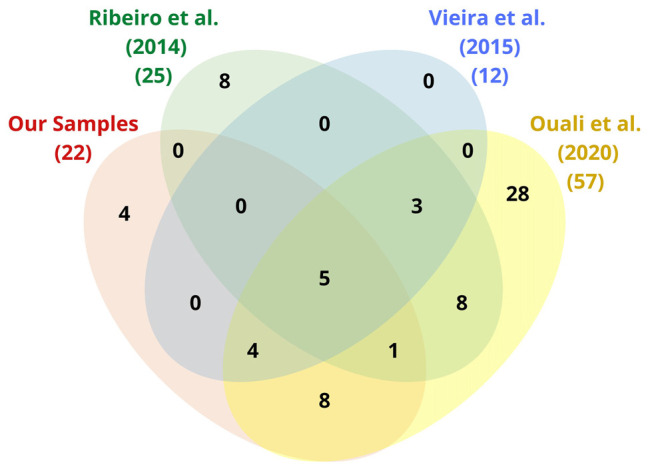
Venn diagram of the immune-related genes found by mapping the sequences of our triatomine samples as well as those of Ribeiro et al. (2014), Vieira et al. (2015), and Ouali et al. (2020) by reference to IIID, KEGG, and NCBI (see Table 3).